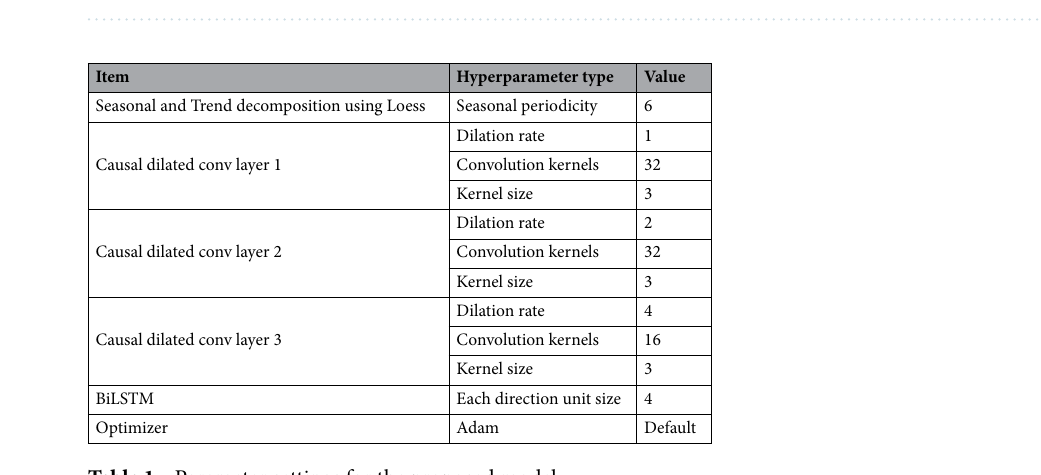
Figure 6. STL-TCN-BiLSTM-DMAttention structure.